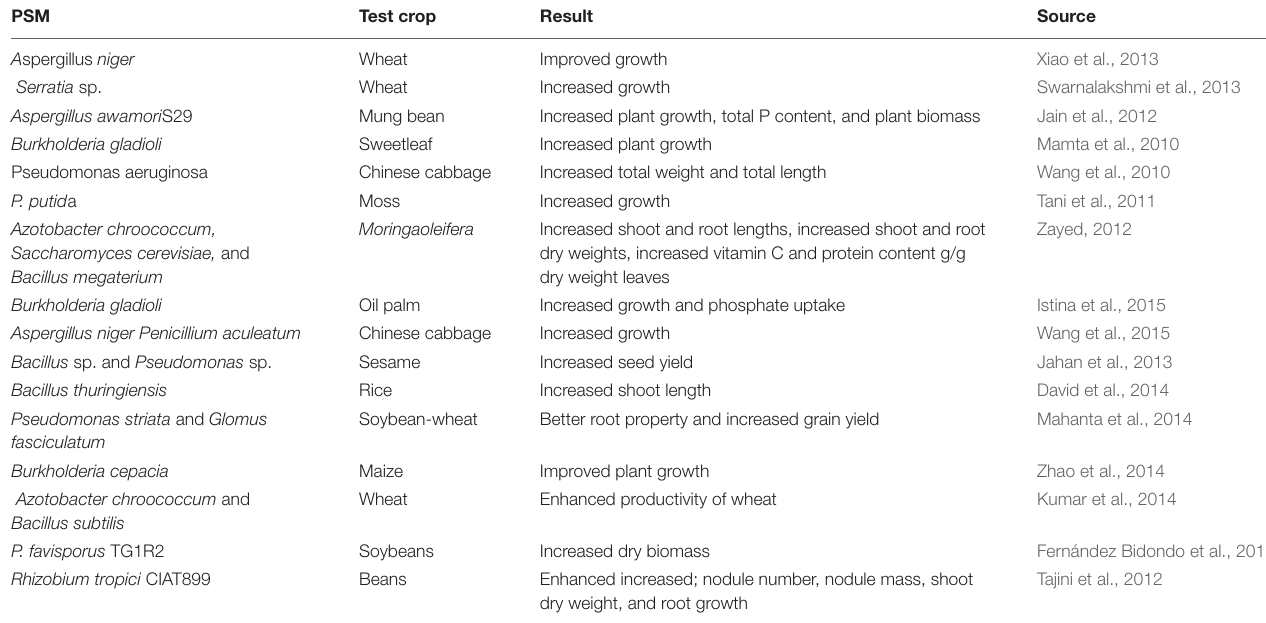
TABLE 1 | Effects of some PSM on